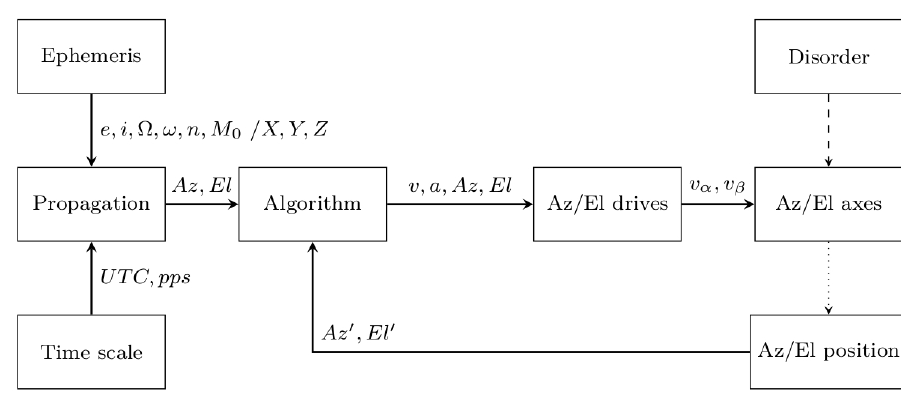
Figure 2. Block diagram of the SLR tracking control